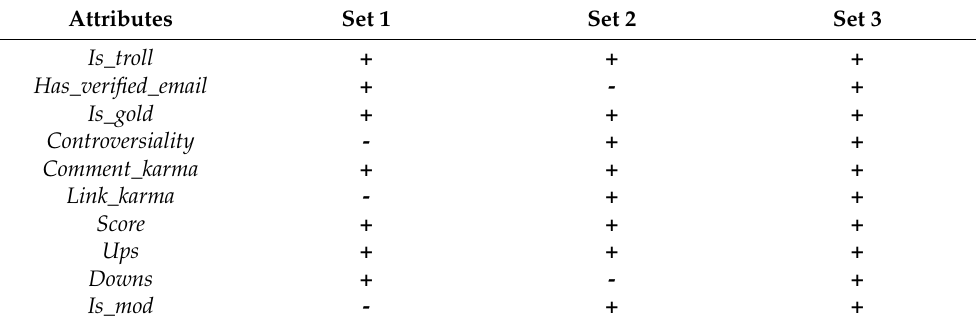
Table 1. Sets of attributes used for learning models using machine learning methods.